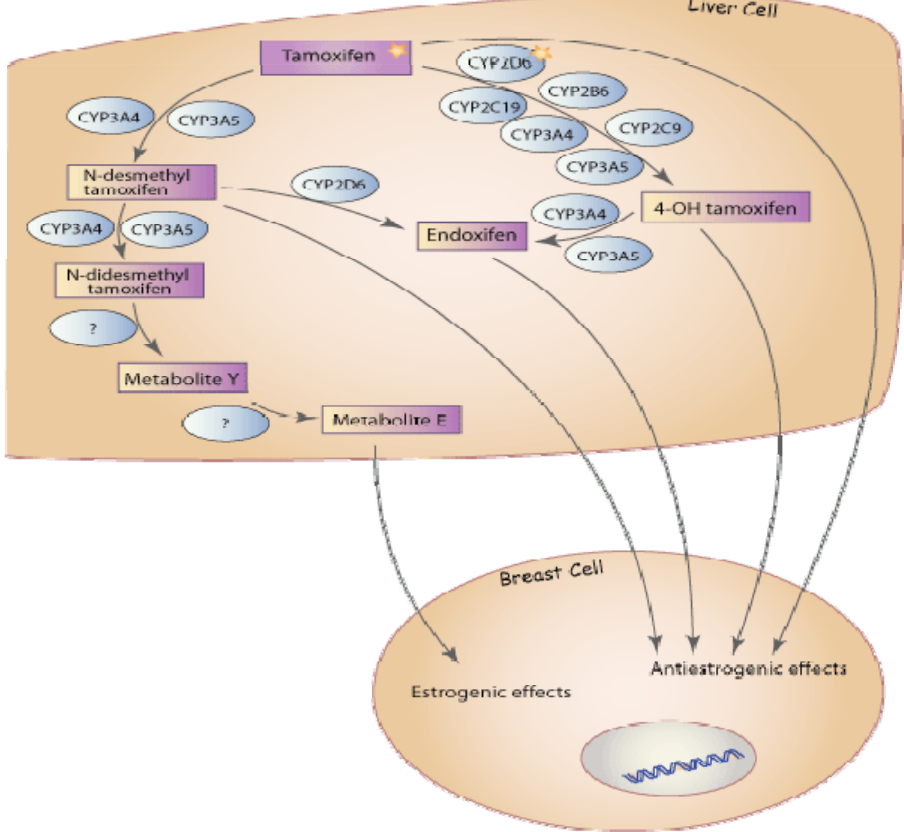
N -desmethyltamoxifen, resulting from CYP3A4/5-mediated metabolism, is the major primary metabolite, accounting for 90% of primary TAM oxidation, whereas 4-hydroxytamoxifen,